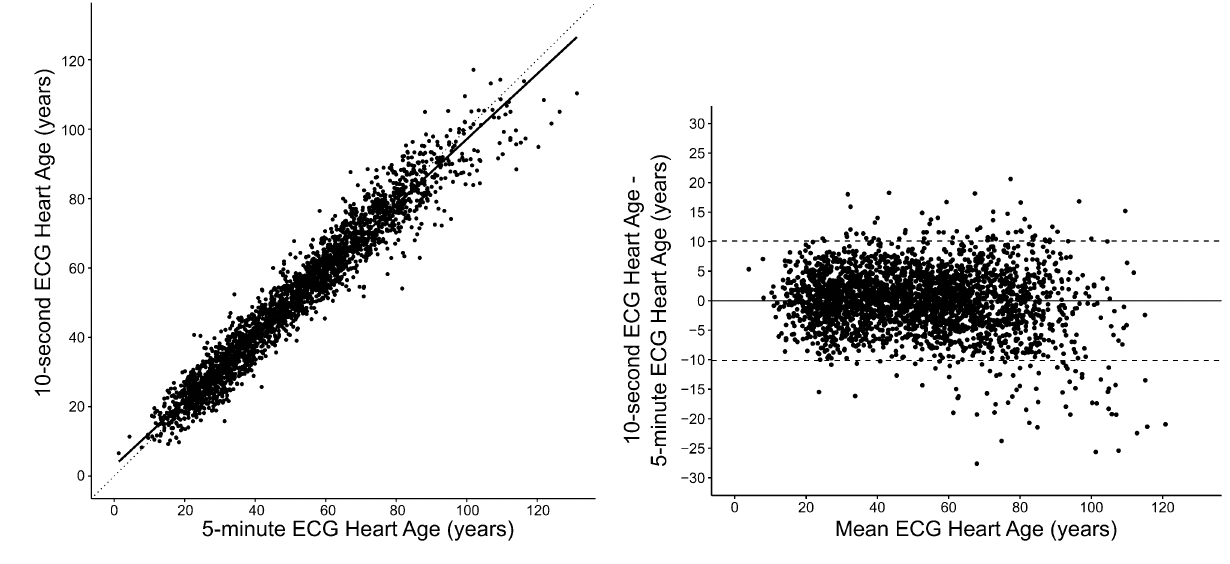
Figure 1. Left panel: Scatter plot showing the relation between the 10-s ECG Heart Age and the 5-min ECG Heart Age in all participants. The R 2 value was 0.94 ( p < 0.001). Right panel: Bland–Altman plot showing the difference between the 10-s and 5-min ECG Heart Age in relation to the mean of both ECG Heart Ages. The agreement between methods is strong, with minimal deviation from the identity line (dashed) or bias (0.0 ± 5.2